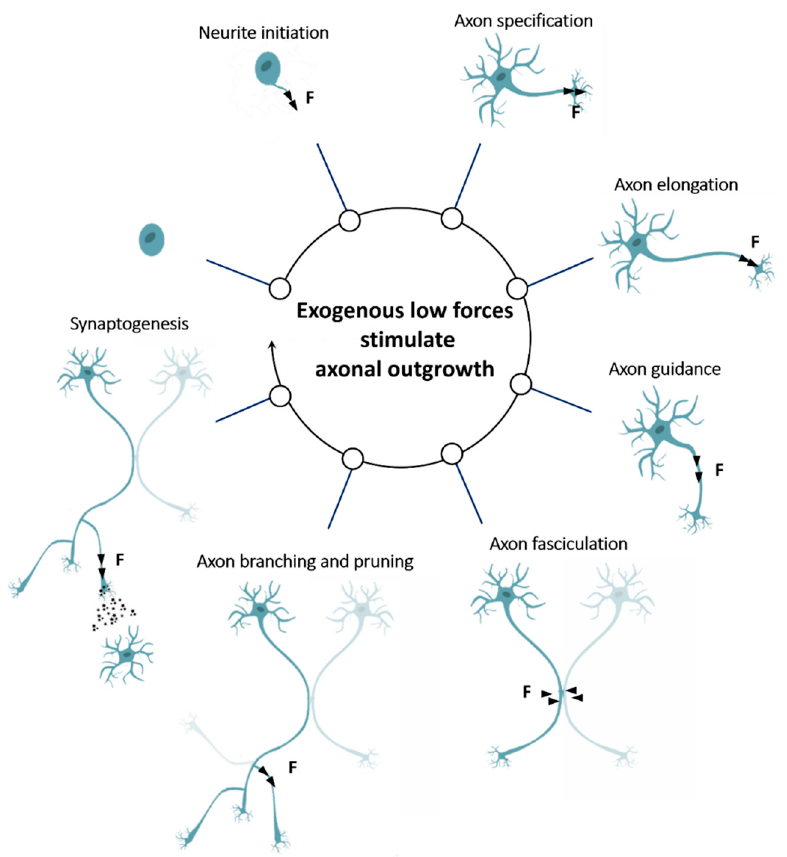
Figure 2. Mechanical force influences every phase of neuronal growth.